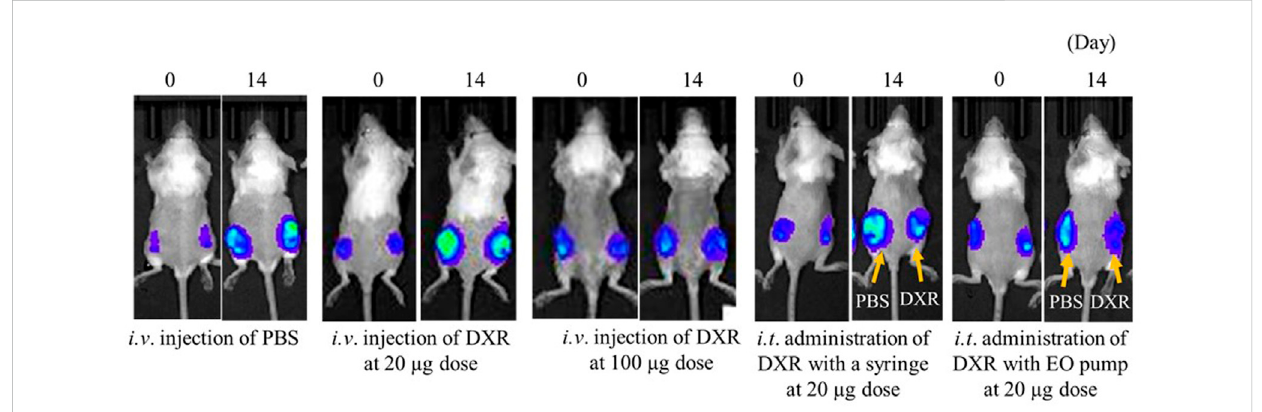
FIGURE 4 Luciferaseluminescenceimageforsubcutaneoustransplanted4T1/Luccellsinmiceafter20 µgor100 µgofDXRwasadministered.Representative images of tumor-bearing mice in each group ( n = 5).